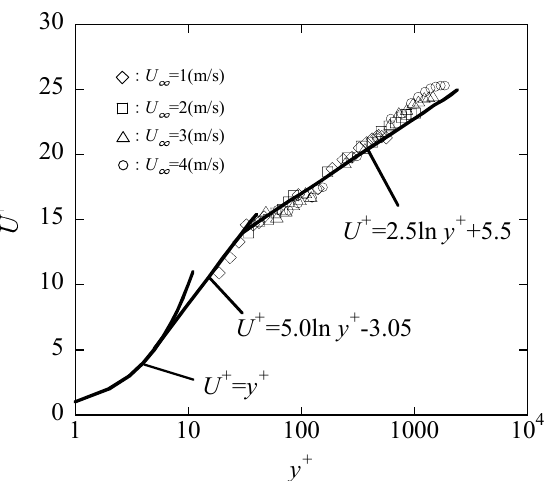
Fig.2 Velocity profile of the turbulent boundary layer as measured by LDV